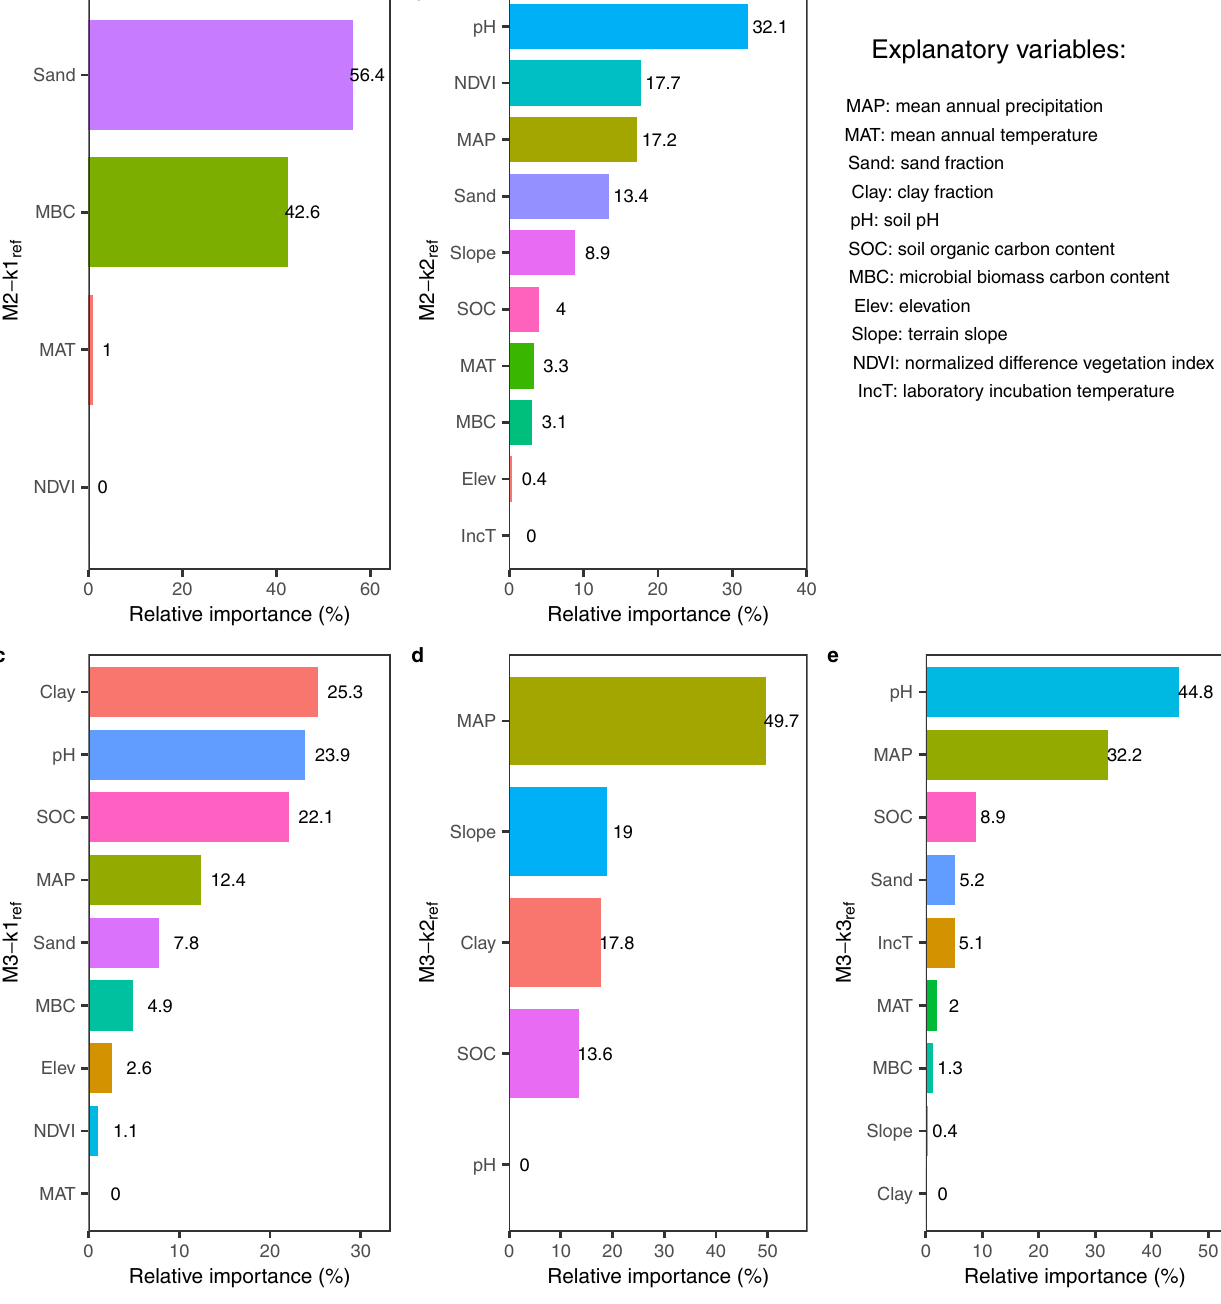
pool (M2-k2 ref ) in the two-pool model. c , d , e Variable importance of the fast (M3- k1 ref ), slow (M3-k2 ref )and passive pool(M3-k3 ref )inthethree-poolmodel.Thesum of the relative importance scores of these variables is